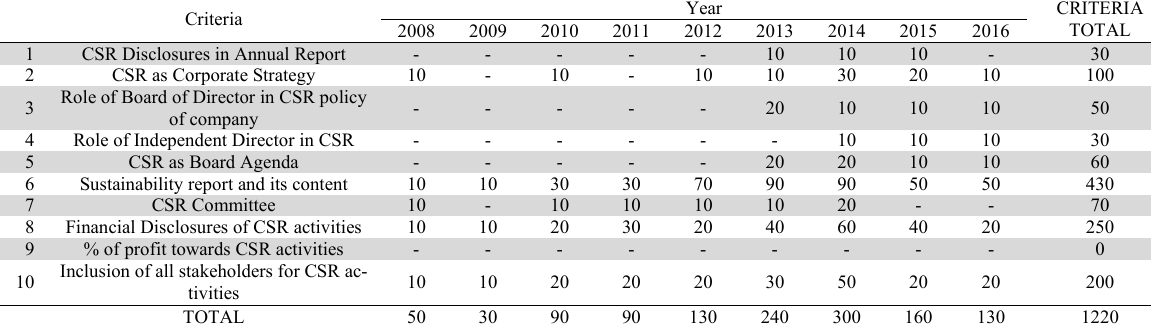
CSR Disclosure Criteria Total Score Criteria